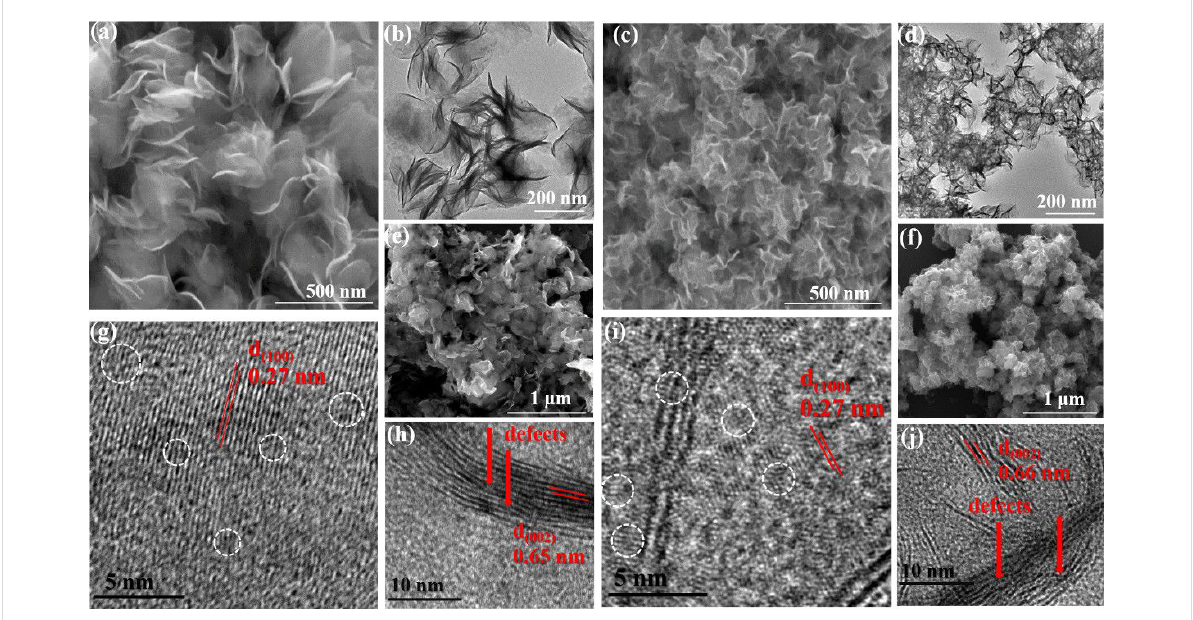
Figure 2: (a) SEM and (b) TEM images of pristine MoS 2 ; (c) SEM and (d) TEM images of C-MoS 2 /rGO; (e) SEM image of MoS 2 -S and (f) SEM image of C-MoS